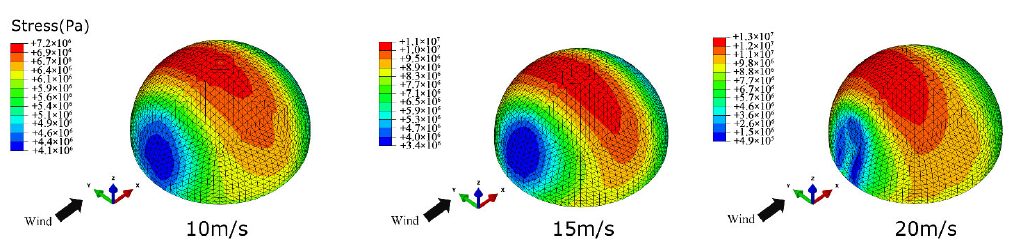
Figure 14. Contours of the maximum membrane stress under different wind velocities ( L = 60 m, H / L = 0.50, p = 300 Pa).